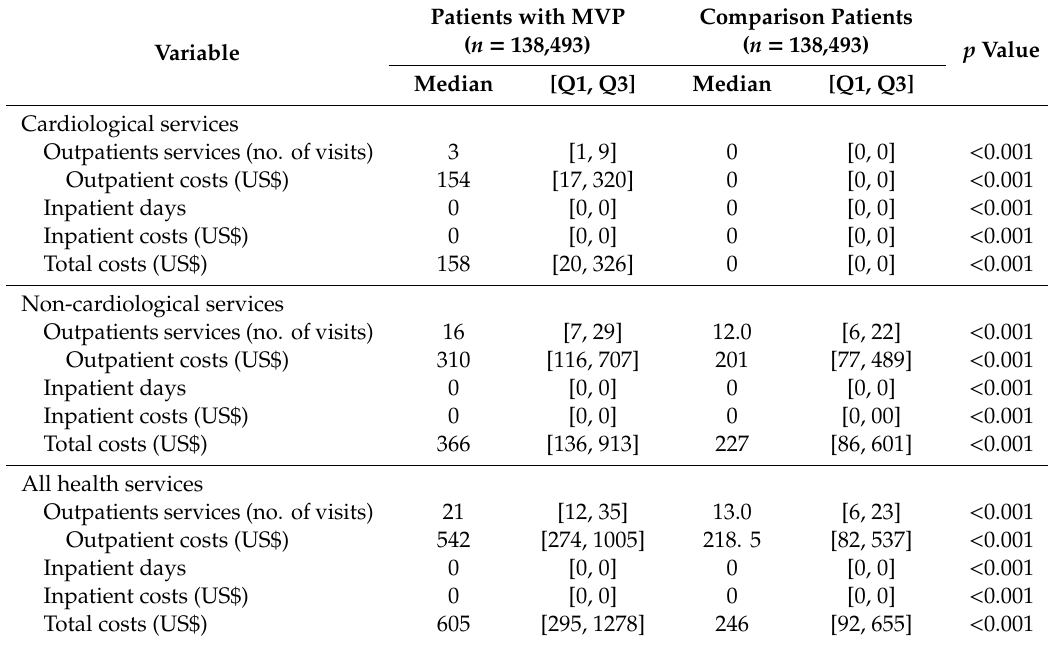
Table 2. One-year Healthcare use and costs (US$)—Patients with and without mitral valve prolapse (MVP) and comparison subjects.